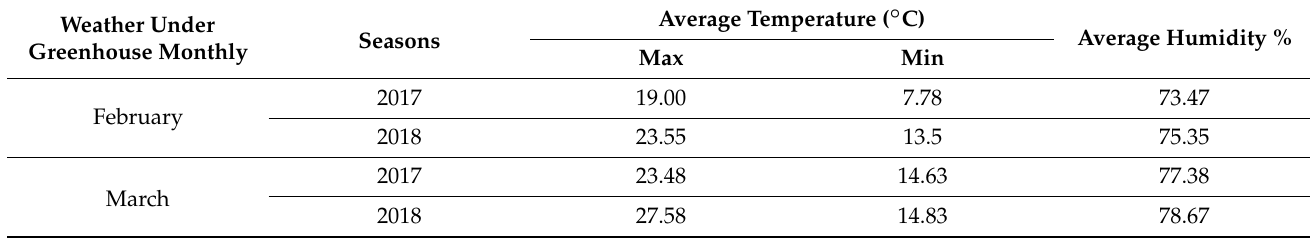
Table 8. Data of average maximum and minimum monthly temperature ( ◦ C), and average monthly humidity (%) for the four growing months (February–May) of the two experimental seasons (2017, 2018). Weather Under Greenhouse